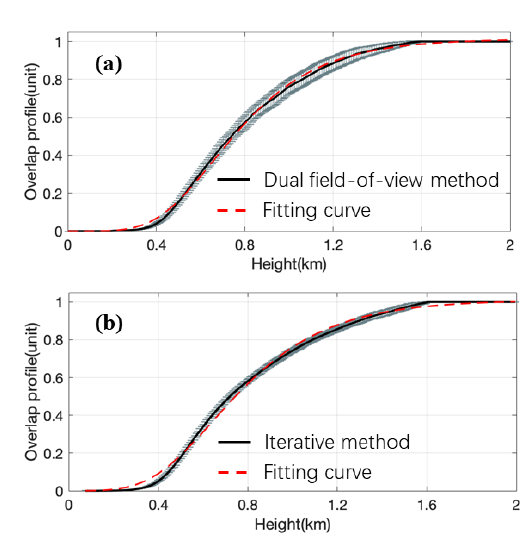
Fig.5 The results of dual field-of-view method (a) and iterative method